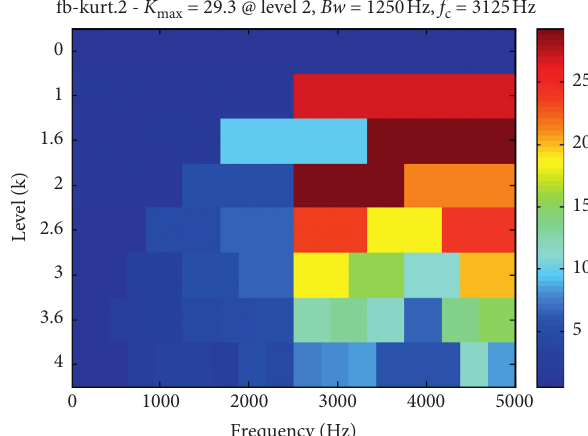
Figure 22: Fast kurtogram of low resonance component of outer race fault.